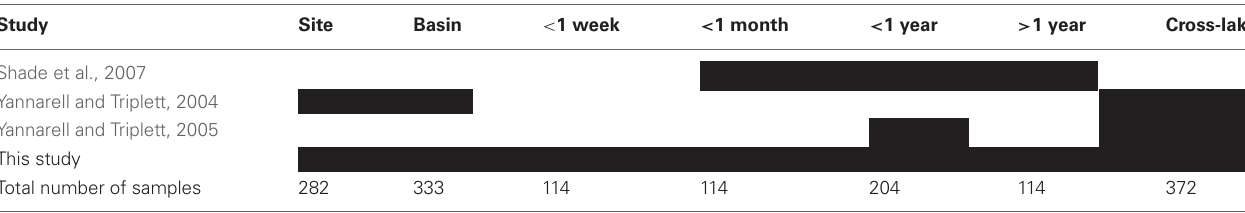
Table 2 | Studies and number of samples included in the comparison of spatial and temporal scales of aquatic bacterial community compositional